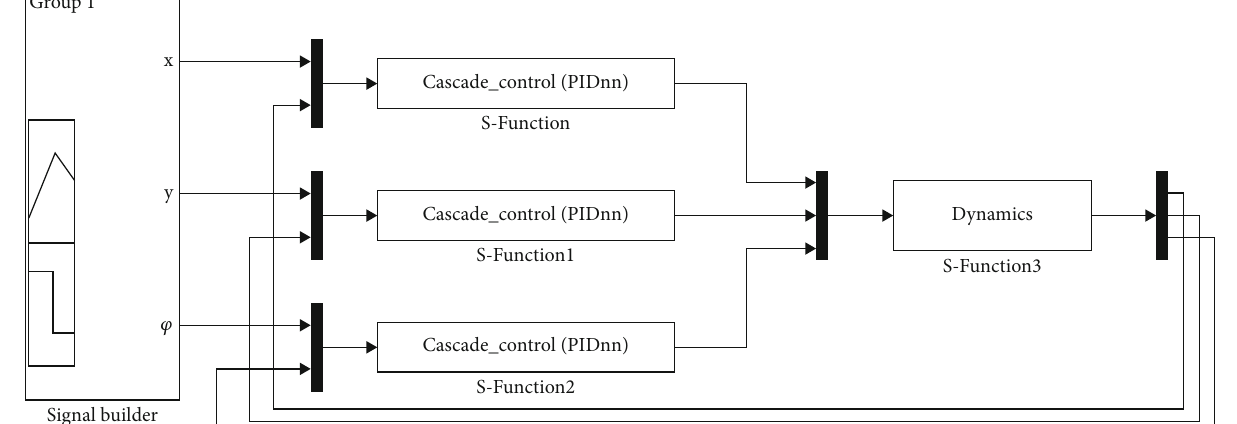
Figure 7: Simulink simulation structural